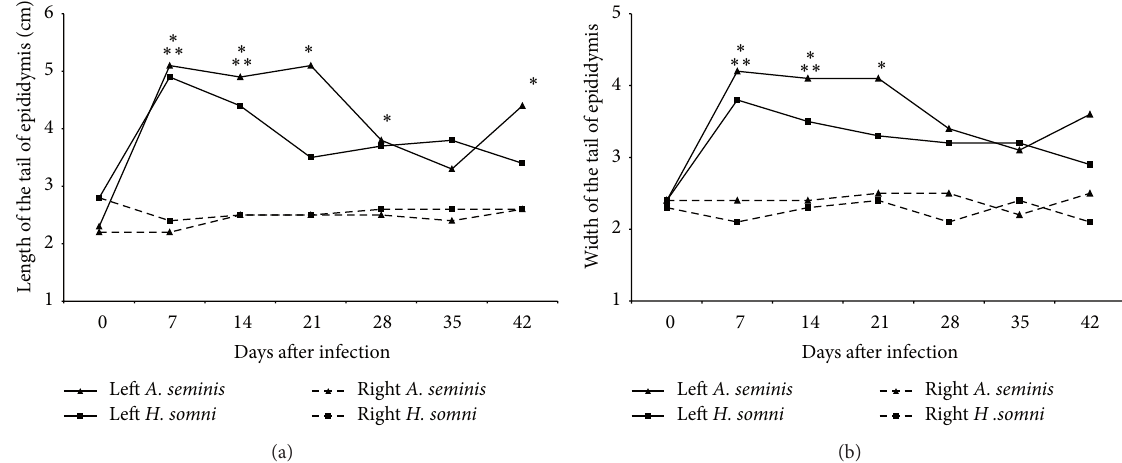
Figure 2: Length (a) and width (b) of the tail of the epididymides of rams experimentally infected with Actinobacillus seminis ( 𝑛 = 10 ) or Histophilus somni ( 𝑛 = 10 ) during the course of infections. Asterisks indicate statistical difference ( 𝑃 < 0.05 ) when compared to preinfection by Dunn test for multiple comparisons ( ∗ A. seminis ; ∗∗ H. somni